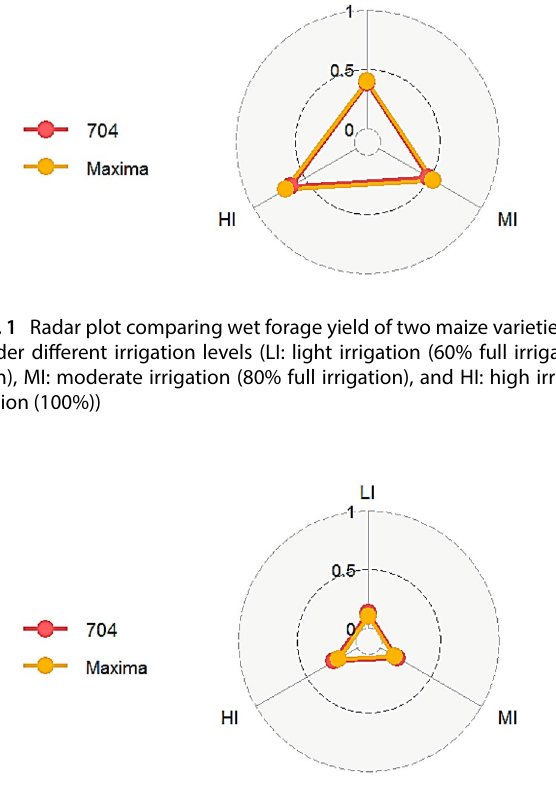
Fig. 2 Radar plot comparing dried fodder yield of two maize vari- eties under different irrigation levels (LI: light irrigation (60% full irrigation), MI: moderate irrigation (80% full irrigation), and HI: high irrigation